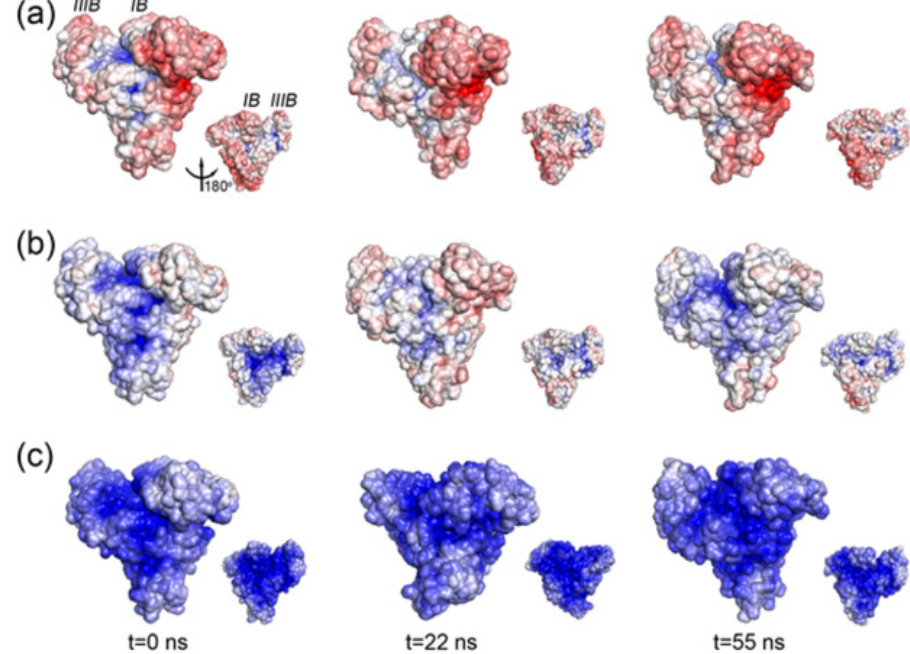
Figure 1. Surface charge distribution for different conformers of albumin ( a ) at pH 6.4; ( b ) at pH 4.7; ( c ) at pH 4.3. Each protein surface is colored as red, white, blue, corresponding to − 10 kT/e, 0 kT/e, and +10 kT/e, respectively. Small-sized cartoon representations display a different perspective, as indicated for one structure at t = 0 ns.